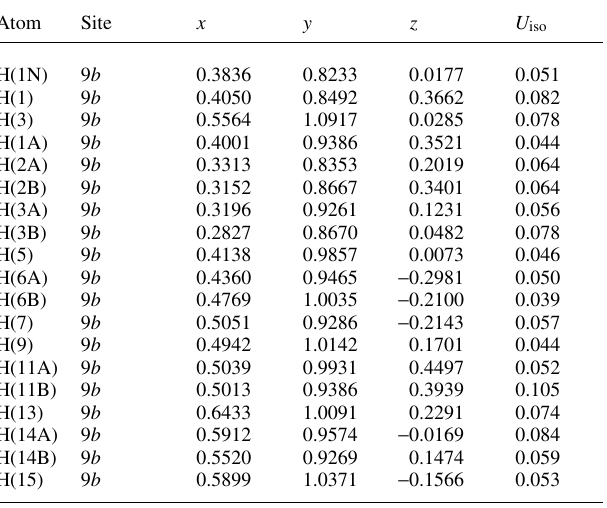
Table 2. Atomic coordinates and displacement parameters (in Å 2 ) .